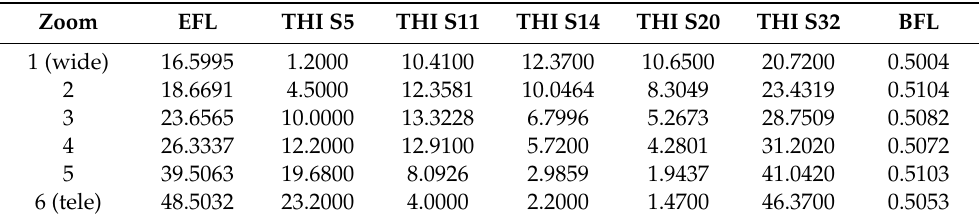
Table 2. Zoom data of the first example in